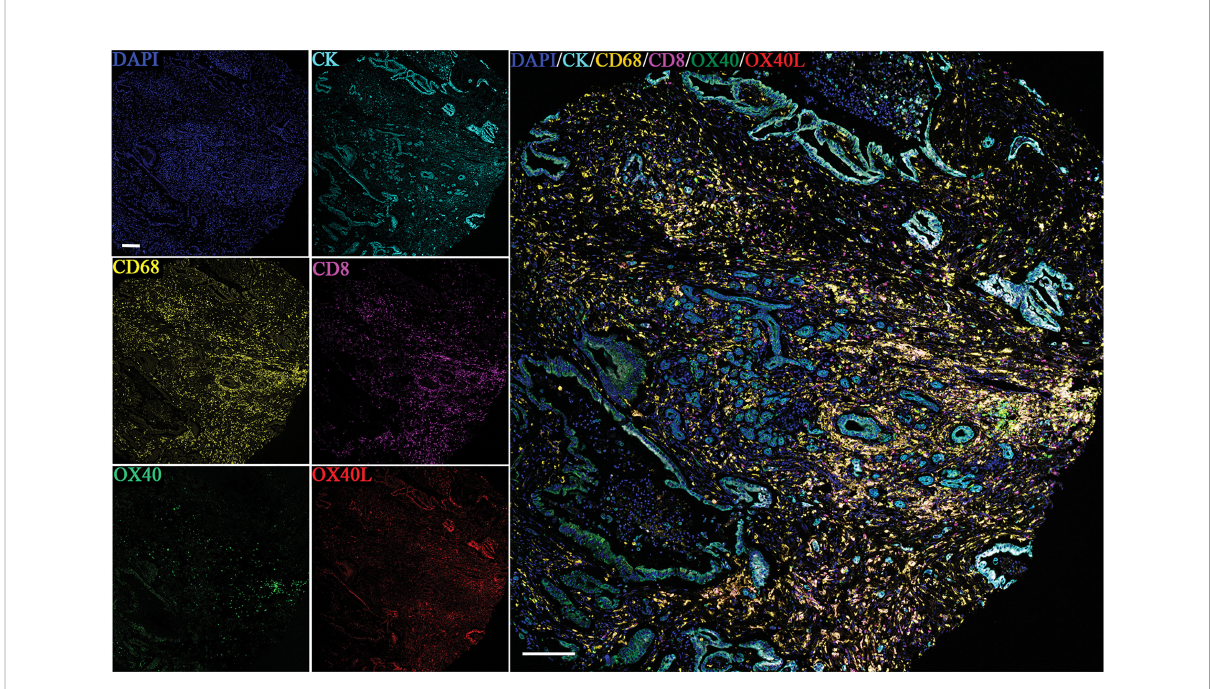
FIGURE 1 Six-color multispectral image and unmixed individual spectral images stained with 4 ′ ,6-diamidino-2-phenylindole (blue), CK (cyan), OX40 (green), OX40L (red), CD68 (yellow), and CD8 (purple). (200×magni fi